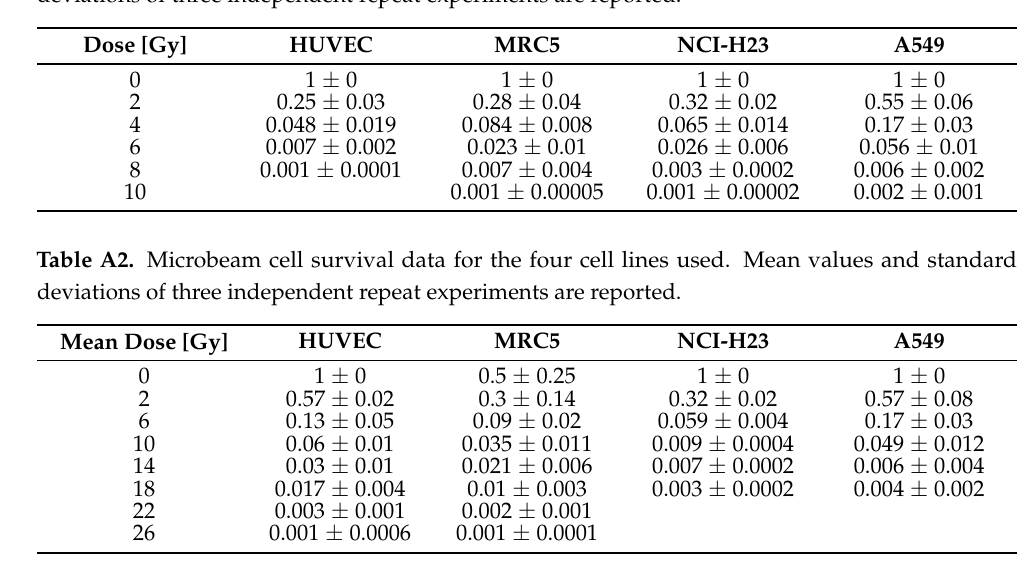
Table A1. Broad beam cell survival data for the four cell lines used. Mean values and standard deviations of three independent repeat experiments are reported.